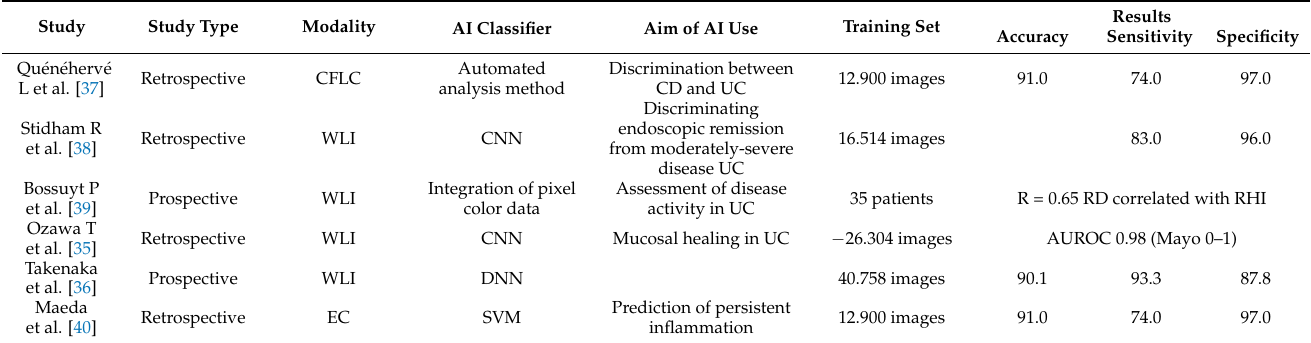
Table 1. Summary of existing studies using artificial intelligence in IBD